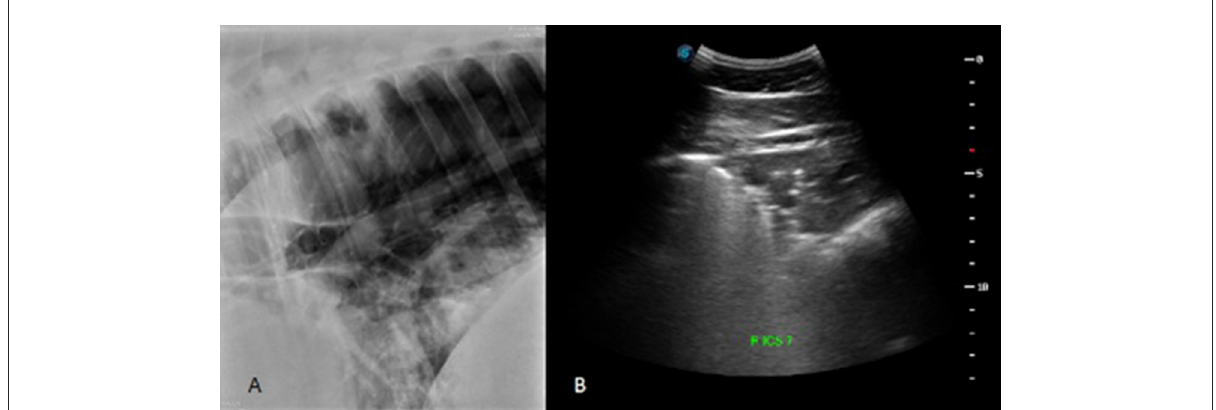
FIGURE4 Radiographic (A) and ultrasonographic (B) image from corresponding sites on a patient in the diseased group. In the caudoventral portion of the lung, the radiograph was classified as having normal/not different presence of a vascular pattern (score of 0), a moderate presence for interstitial and alveolar patterns (score of 1 for each pattern), and a marked presence of a bronchial pattern (score of 2). The total radiographic score for this patient was 9. The ventral portion of right ICS 7 was given a comet tail score of 3 and a score of 4 for the presence of pulmonary consolidation. The total US score for this horse was 283.